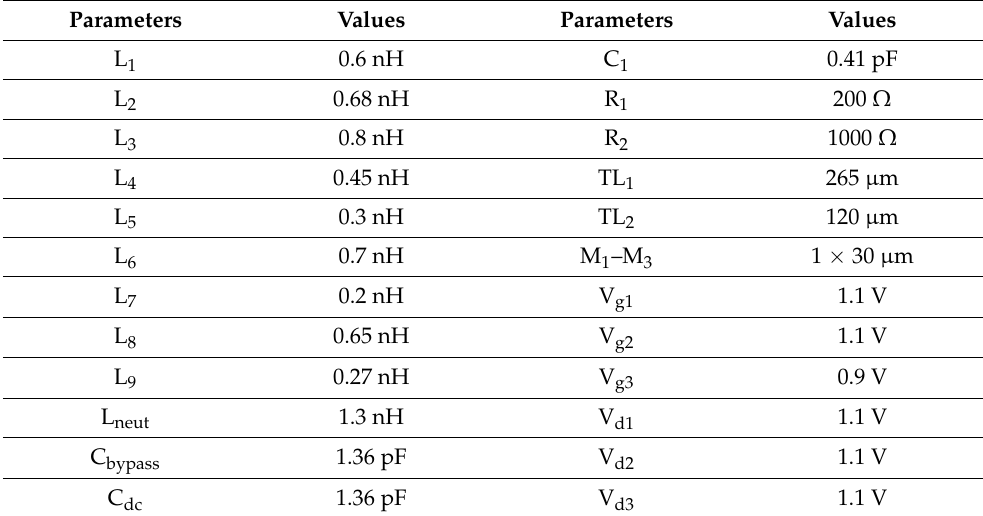
Table 1. Design parameter values of the full Ka-band amplifier.